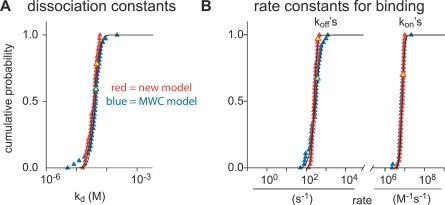
Properties of the Independent SiteThe 38 fit results for the k
on's, k
off's (B), and K
d's (A) of the independent site (V) have a log-normal distribution for both models. This can be seen when the data of the new model (red symbols) and the MWC model (blue symbols) are plotted on a logarithmic scale as a cumulative probability plot. The k
on's, k
off's (B), and, k
d's (A) were fitted (solid lines) with a single log-normal function, indicating a uniform result for the 38 fits. The yellow symbols are derived from the dataset shown in Figure 3.